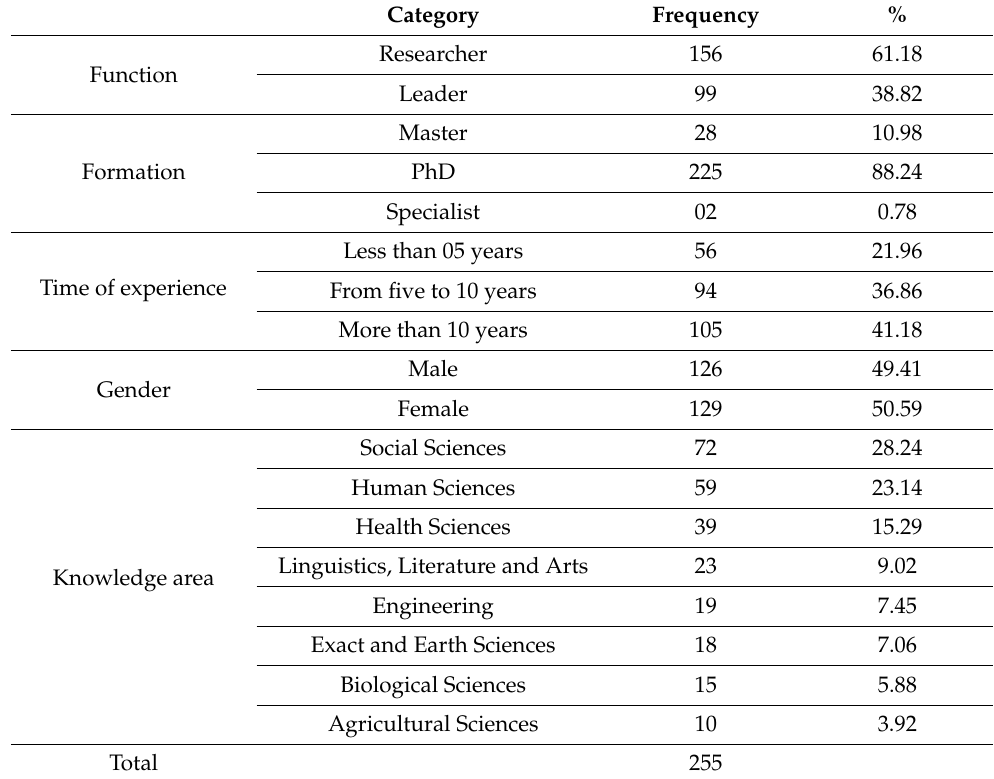
Table 1. Demographic profile